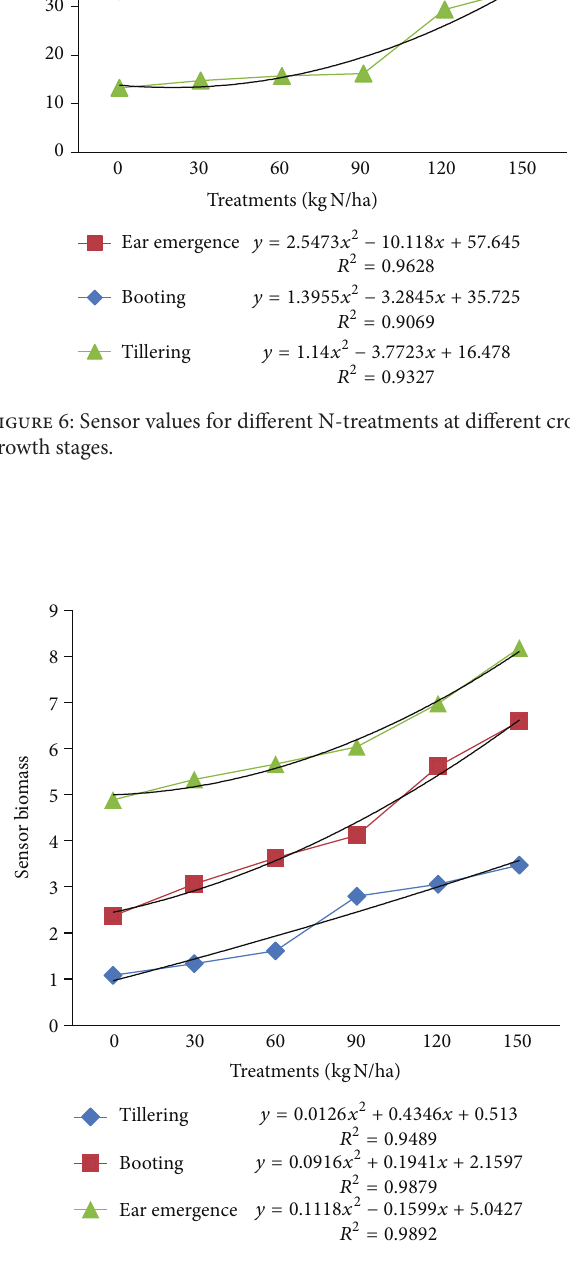
Figure7:BiomassvaluesfordifferentN-treatmentsatdifferentcrop growth